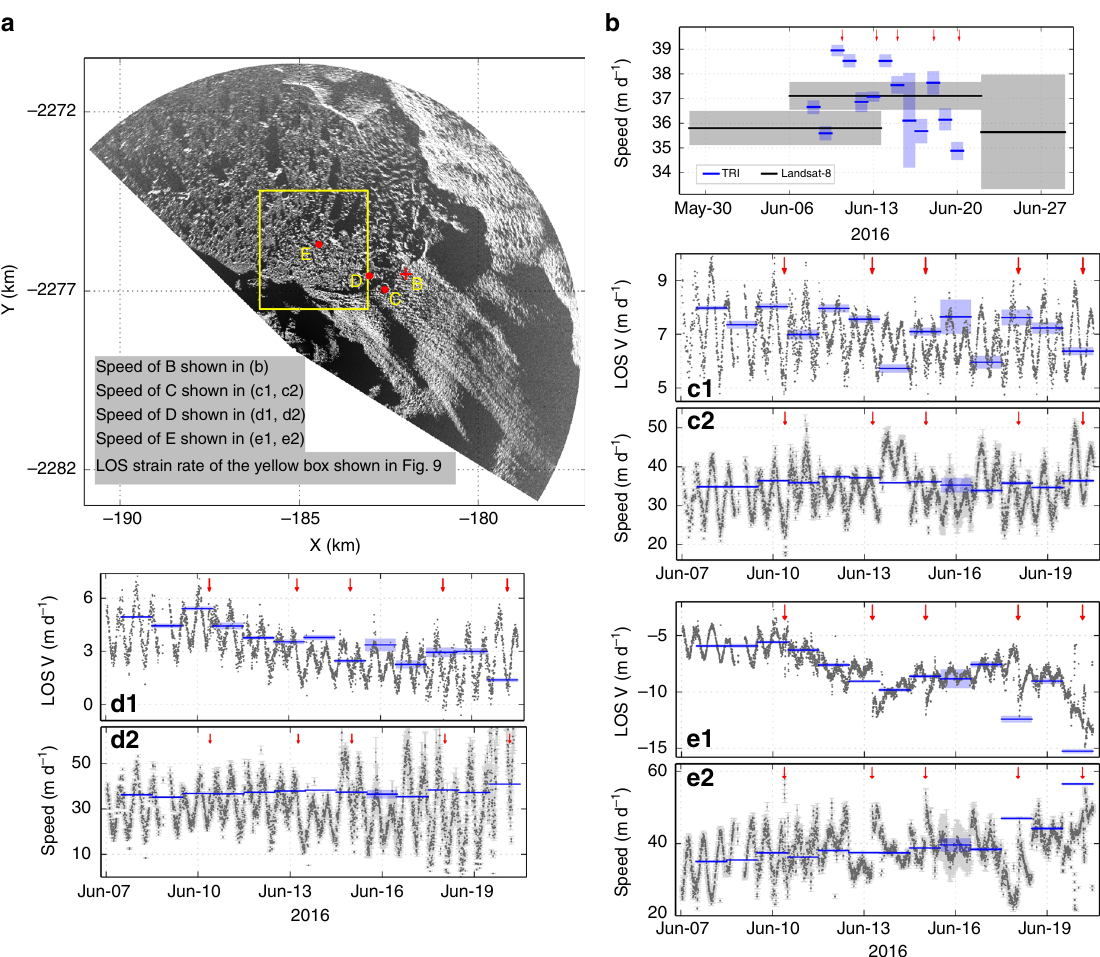
Fig. 8 Speed responses to calving-like collapses. a B marks a Lagrangian point that is ~200 m to the glacier front. C – E represent three Eulerian points: C is on the glacier and within 600 m of the front throughout the TRI observations; D is in the mélange adjacent to the glacier and by the end of TRI campaign it was ~100 m from the glacier front; E is another mélange point and by the end of TRI campaign, it was ~300 m upstream from the elevation step-change in the mélange. b – e2 Blue lines show (LOS-projected) feature tracking speeds from TRI pairs, transparent blue marks uncertainty; black lines in b show feature tracking speeds from Landsat-8 pairs, grey marks uncertainty. Red arrows mark major calving-like collapse events within the mélange, some of these events can last >3 h and red arrows mark times when the TRI images show most signi fi cant capsizing motion. c1, d1, e1 Grey dots show TRI-derived LOS velocities from interferometry 6 (positive is de fi ned as ice moving towards the radar, negative is away from the radar). c2, d2, e2 Grey dots with light grey error bars are inverse-projected speeds based on LOS velocities and observation geometry, assuming that the angle between radar LOS and ice velocity is the same as estimated from feature tracking of an image pair separated by a day. Note instantaneous speed increase (decrease of positive LOS velocity) in e1 after each major calving-like collapse event. Also note that a jump at 12:00 13 June 2016 in c2 does not correspond to any calving-like collapses (the closest calving-like event is ~6 h before) and is likely caused by error in fl ow direction